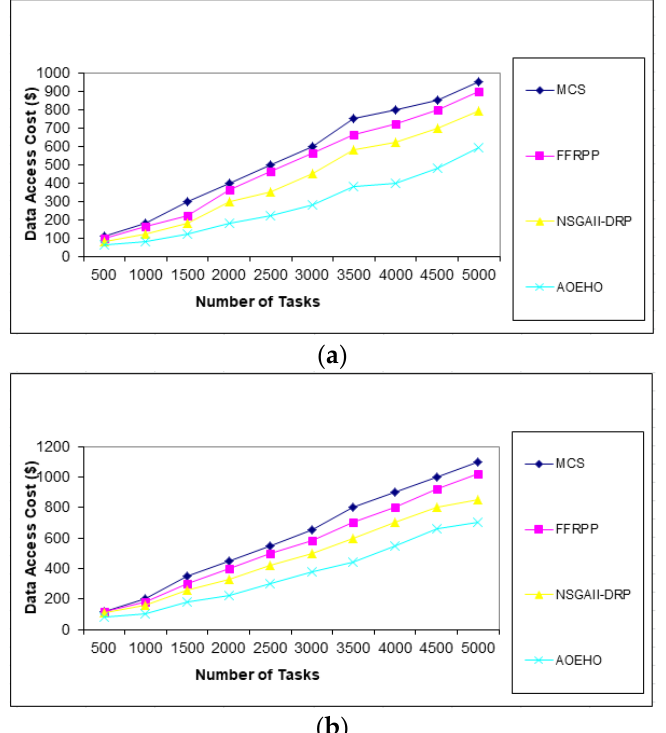
Figure 4. Cost number of tasks and cost = 5000 tasks. ( a ) Size of data replication = 64 MB. ( b ) Size of data replication = 320 MB.